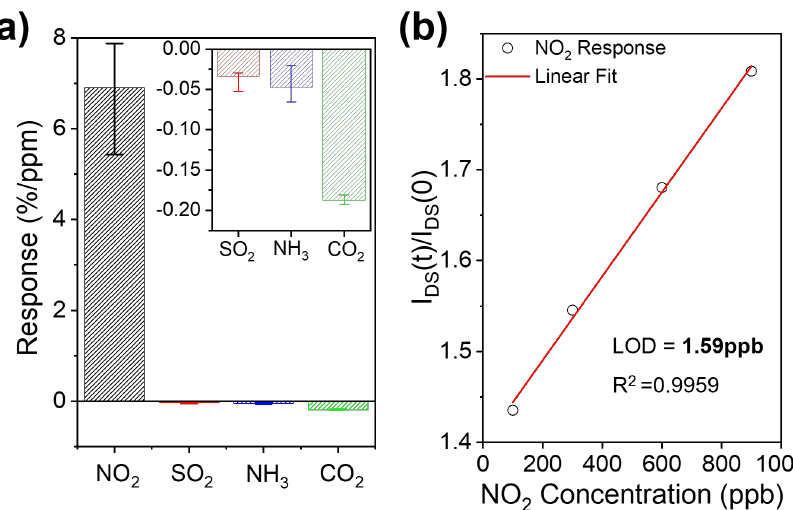
Figure 7. ( a ) Detection selectivity and ( b ) the calculated theoretical LOD of a resistive sensor adopting PTQ-TEG .